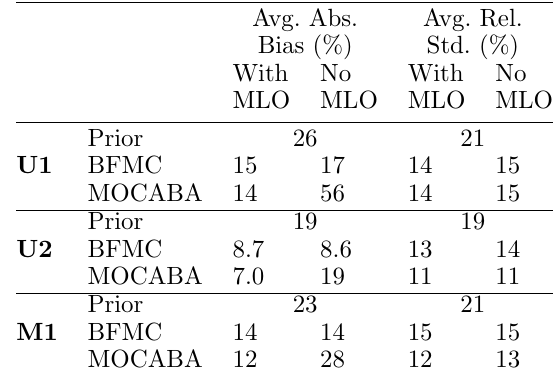
Table 6. Analysis of bias and uncertainty of posterior calculated FP concentrations. Avg.